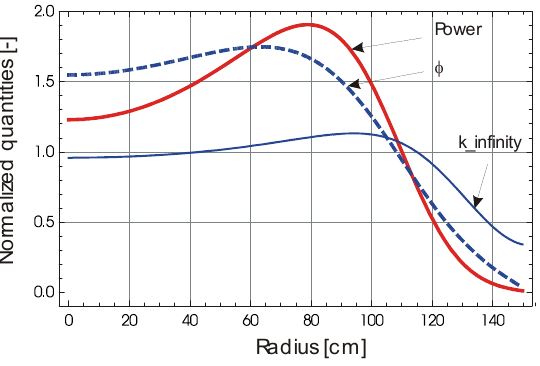
Figure 4. Distributions of power, neutron flux and k_infinity ( k shuffling of Case 2 in Table 2.